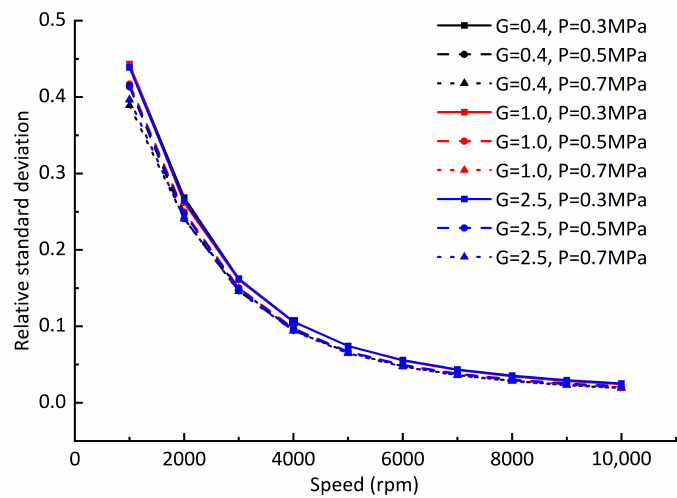
Figure 14. Relative standard deviation of dynamic equilibrium position offsets (adding load F = 65 N).